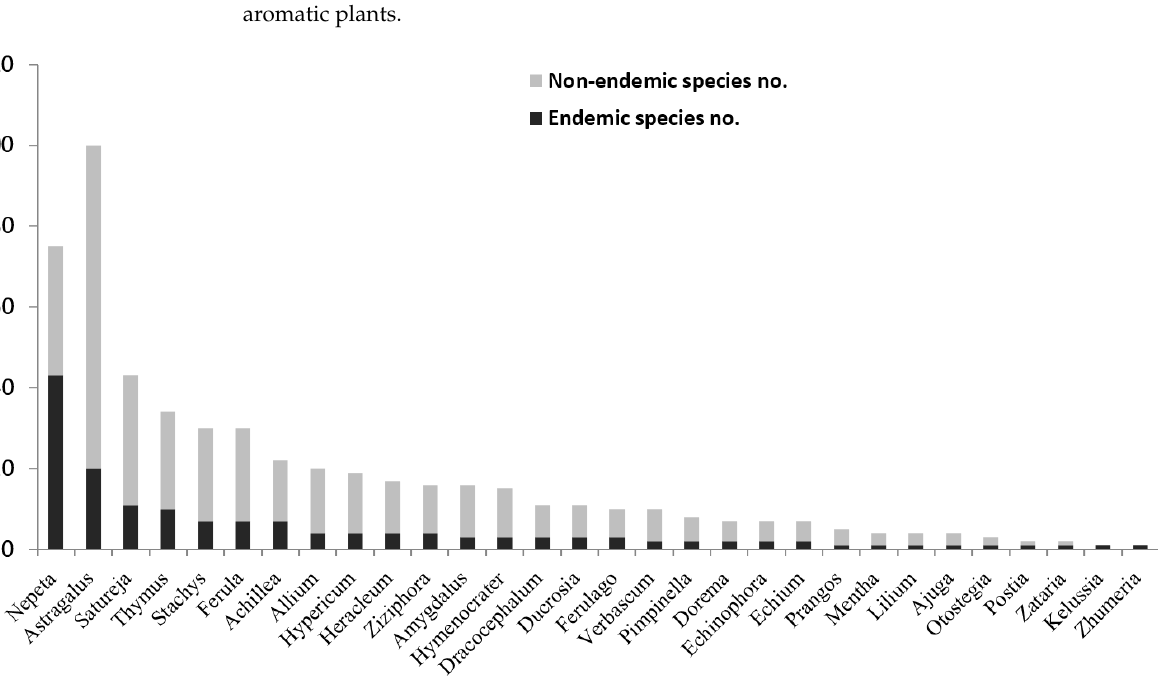
Figure 2. The frequency of endemic and non-endemic species of the 30 most endemic-rich genera of the Iranian medicinal and aromatic plants.